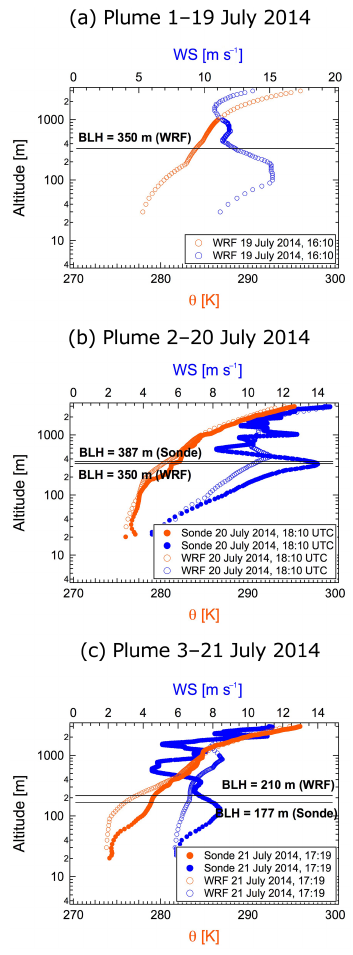
Figure 4. Vertical profiles of potential temperature ( θ ) and wind speed (WS) as measured with radiosondes launched from Amund- sen and WRF (interpolated in space and time to the radiosonde launch location) during plumes 1 (a) , 2 (b) , and 3 (c) . We note there was no radiosonde launched on 19 July 2014. The boundary layer height (BLH) calculated from the radiosonde and WRF data are shown with black horizontal